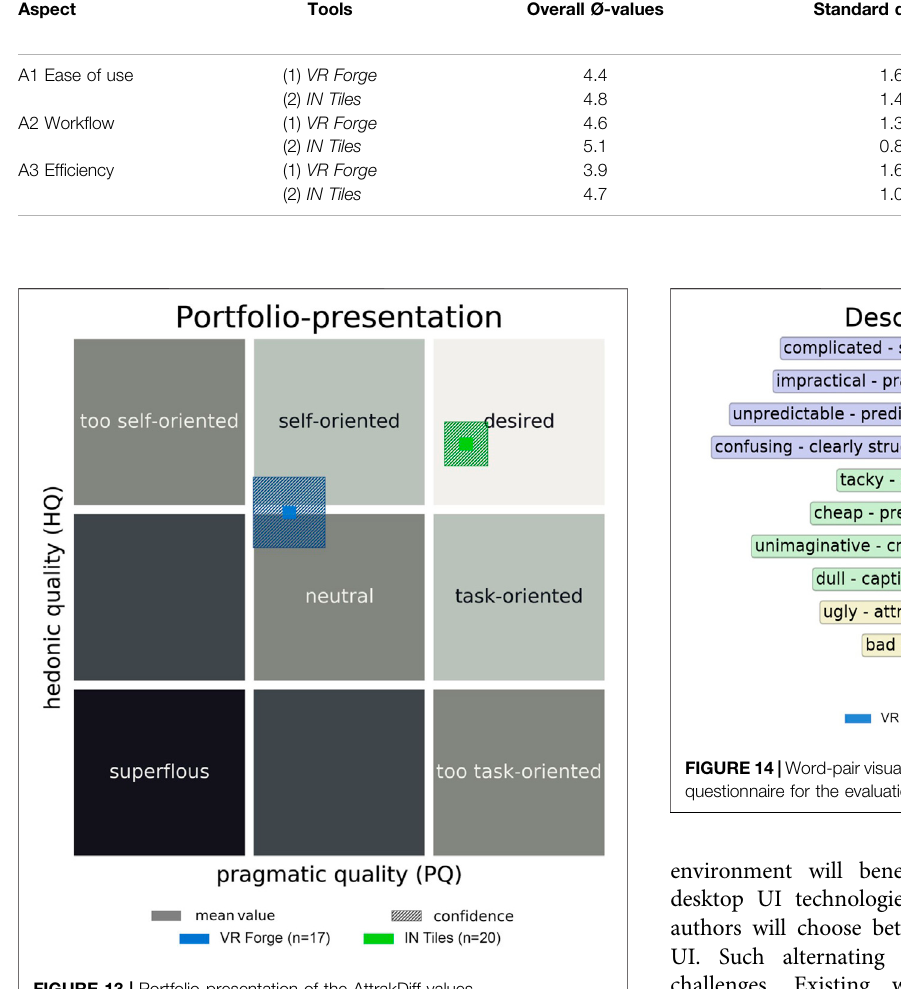
FIGURE 13 | Portfolio-presentation of the AttrakDiff values.